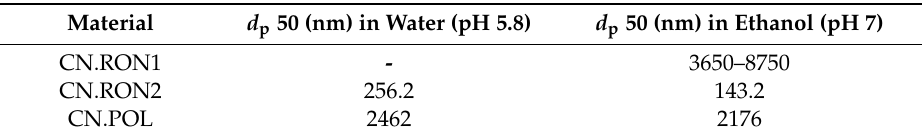
Table 3. Mean particle size of nanomaterials in suspension.